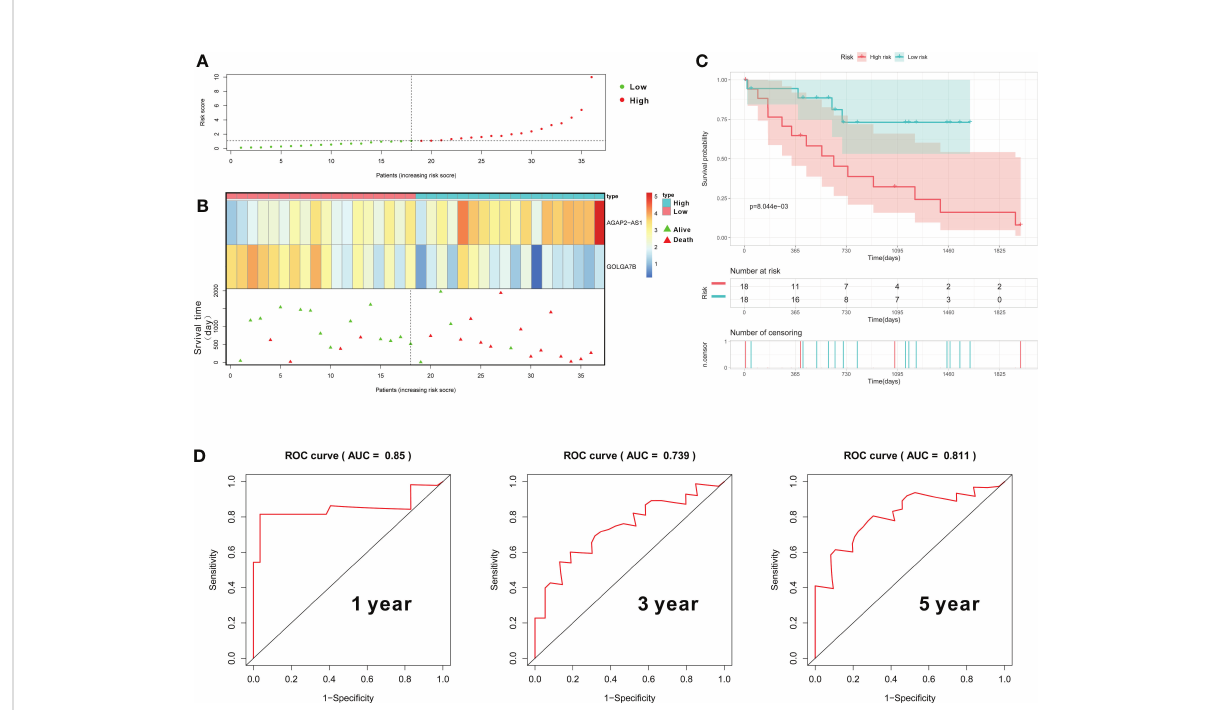
FIGURE 5 Construction and validation of the gene prognostic signature in the training group. (A) The risk plot shows the RS of each CCA patient. (B) The risk plot shows that CCA patients with higher RS values exhibited lower expression of GOLGA7B , higher expression of AGAP2 − AS1 , and a better survival rate. (C) Kaplan – Meier curves con fi rmed that CCA patients in the high-risk group had a poorer survival probability. (D) ROC curve to evaluate the diagnostic competence of the two-gene prognostic predictive signature based on the expression of GOLGA7B and AGAP2 − AS1